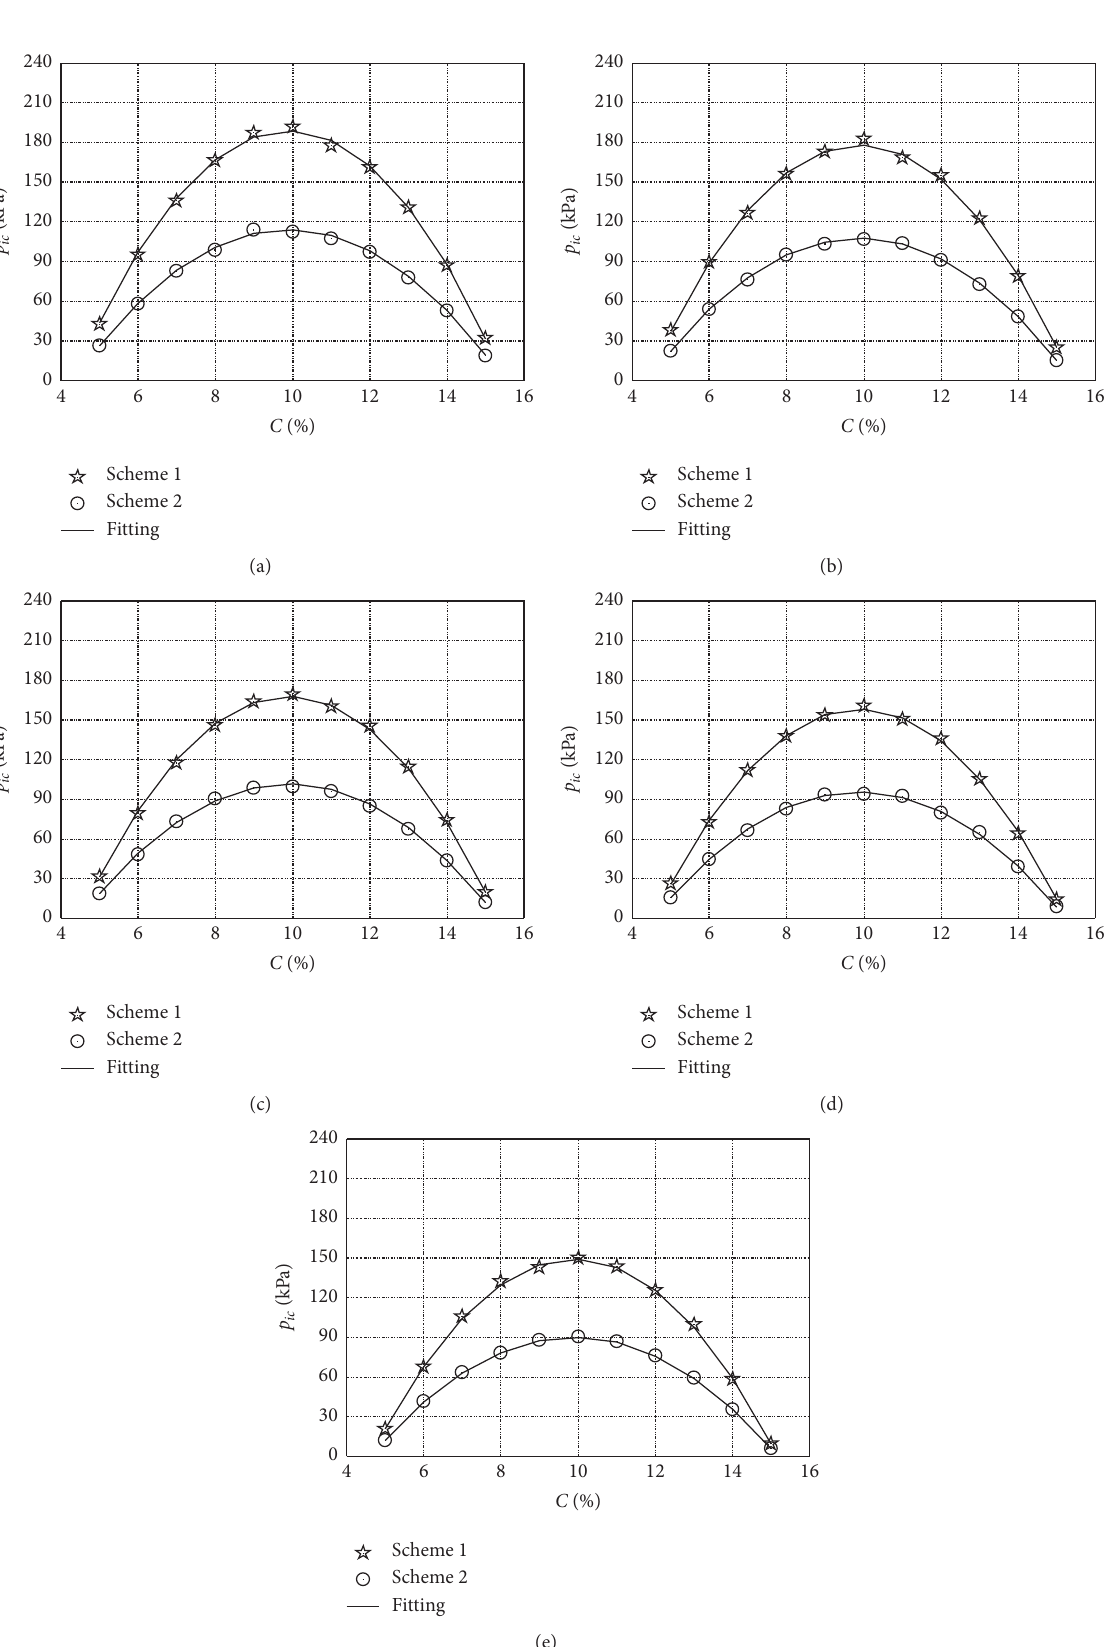
� − 60 ° C (b) (T) � − 30 ° C. (c) (T) � +0 ° C